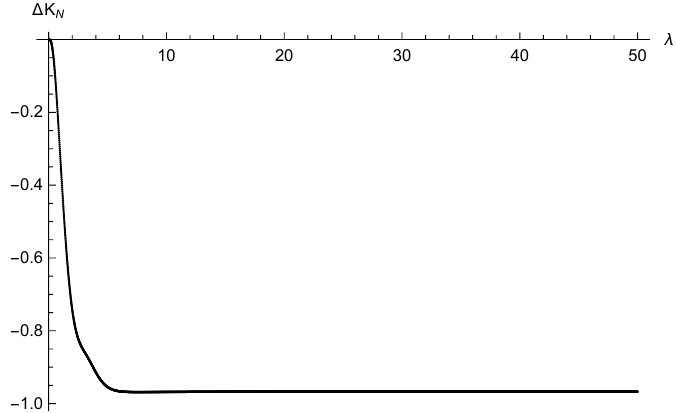
Figure 3. ∆ K N as a function of λ , considering H 2 and the initial conditions I.